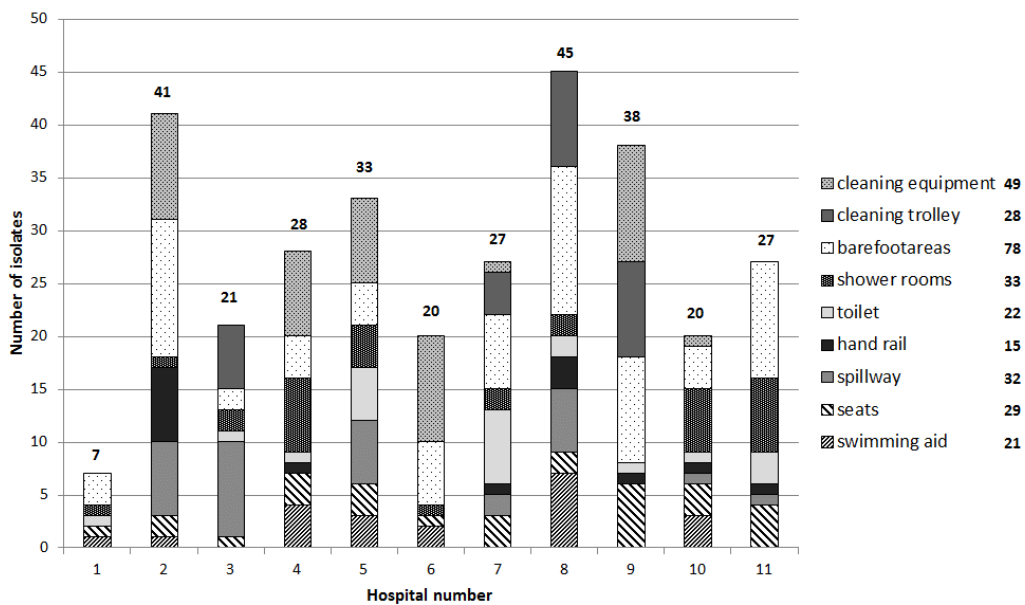
Figure 1. Number of antibiotic-resistant isolates (growth on selective media) from the surrounding surface samples ( n = 371).